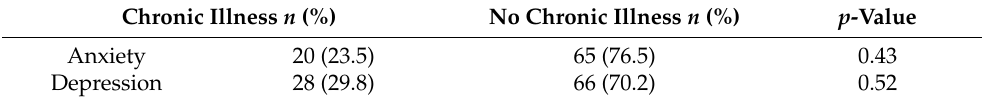
Table 3. Description of anxiety and depression results stratified by pre-existing chronic illness.